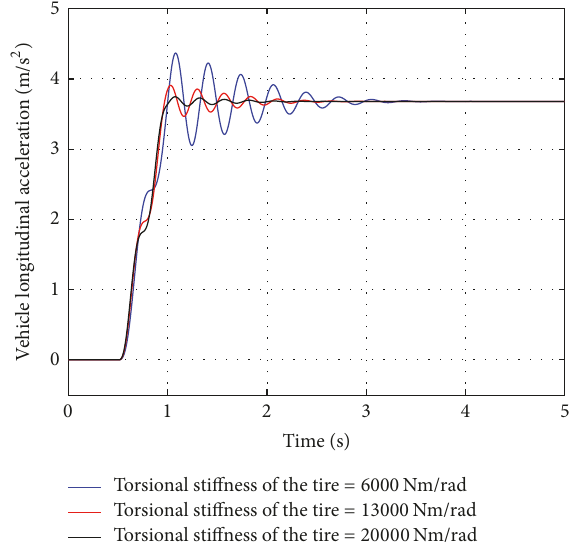
Figure 9: Longitudinal acceleration of the model with/without the tire torsional stiffness. Figure 10: Sensitivity analysis: effect of the variation of the torsion stiffness 𝑘 𝑡 of the tire.